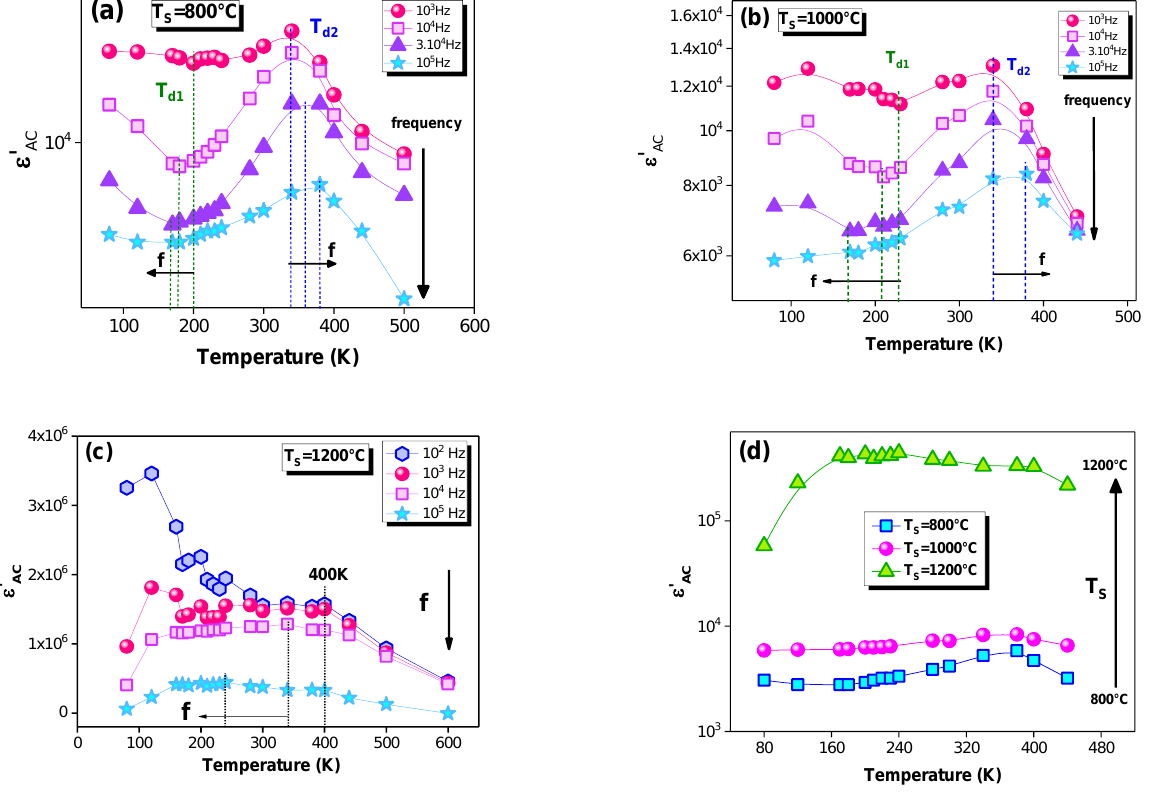
Figure 8. Temperature dependences of the dielectric constant ( ε′ ) at different frequencies for the La 0.9 Sr 0.1 MnO 3 compound sintered at ( a ) 800, ( b ) 1000 and ( c ) 1200 ◦ C. ( d ) Evolution of the dielectric constant ( ε′ ) with temperature at different sintering temperatures (TS).